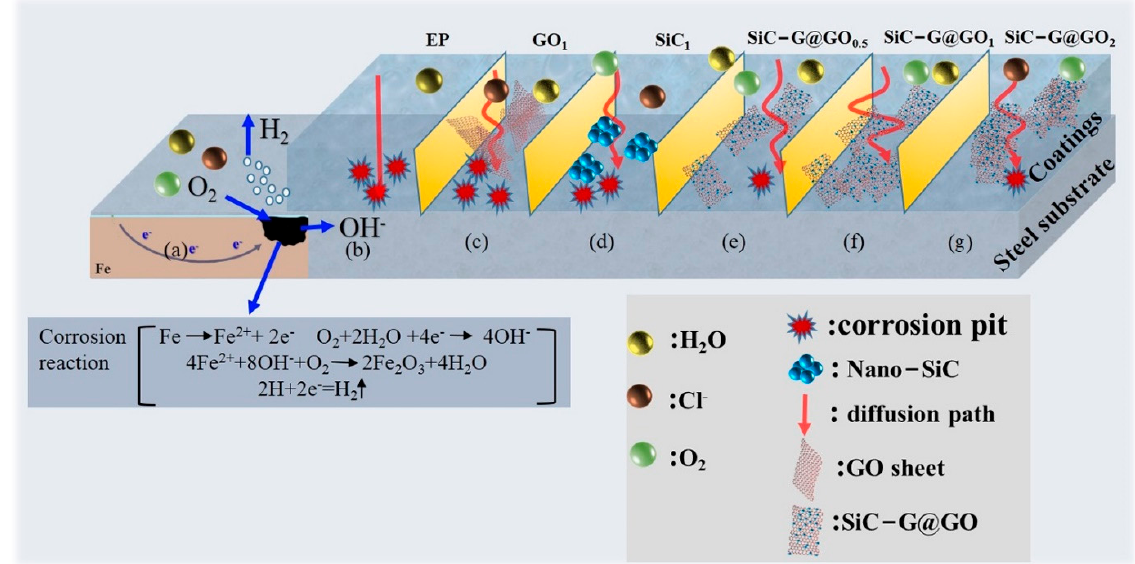
Figure 16. ( a ) Corrosion of iron-based surfaces exposed to air. Anticorrosion mechanism of ( b ) neat EP, ( c ) GO 1 , ( d ) SiC 1 , ( e ) SiC-G@GO 0.5 , ( f ) SiC-G@GO 1 , and ( g ) SiC-G@GO 2 .